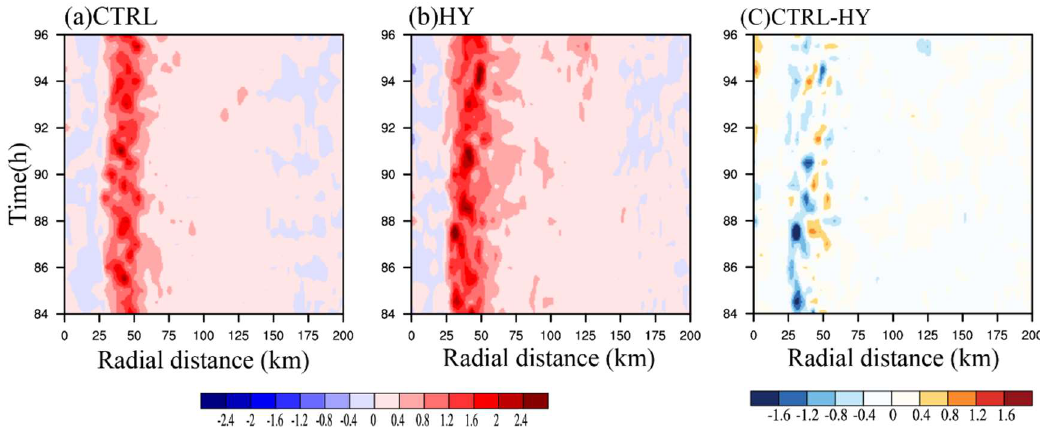
Figure 5. Time evolution of azimuthal mean vertical winds (color shade, m s − 1 ) for ( a ) CTRL, ( b ) HY and ( c ) CTRL-HY at 6 km in altitude, averaged between 84 and 96 h.